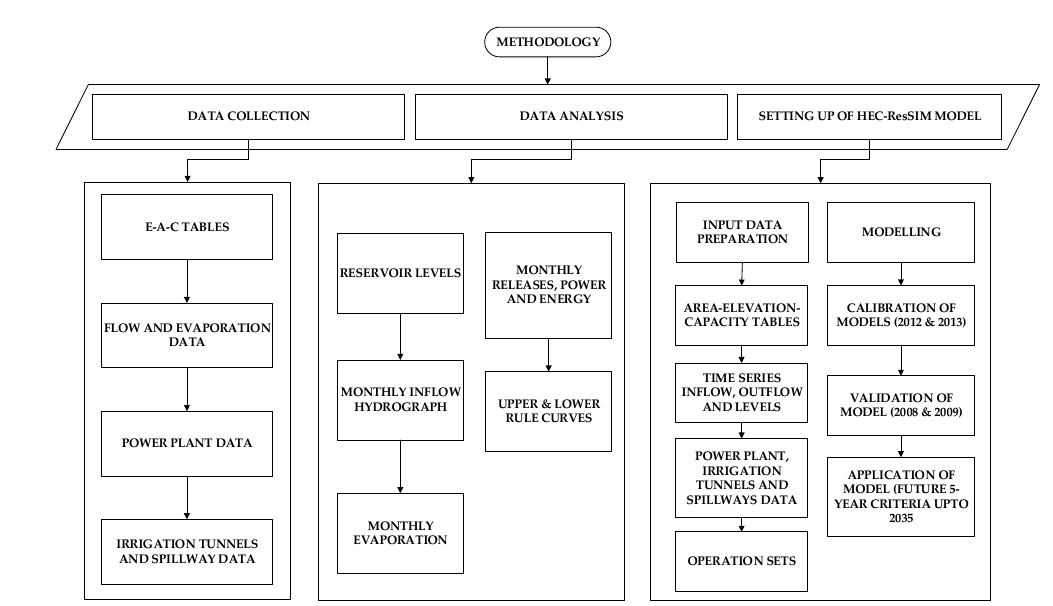
Figure 6. Flow Diagram showing the Methodology of the Study.